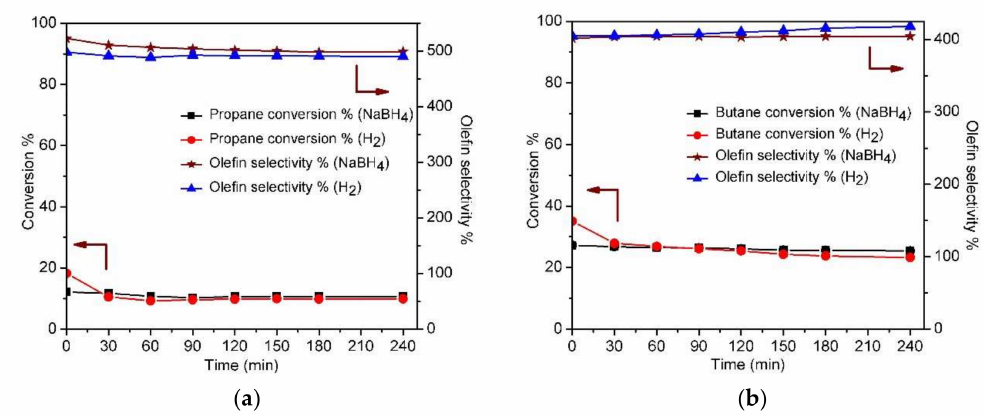
Figure 5. Conversion and selectivity over NaBH 4 and H 2 reduced catalysts on ( a ) propane only feed and ( b ) butane only